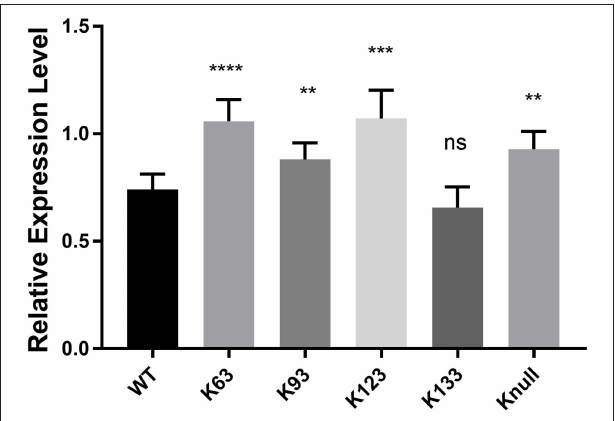
FIGURE 7 | TRP32 lysine mutants exhibit decreased repression of target gene transcription. Wild type and lysine mutant GFP-TRP32, or a GFP control were transfected into HeLa cells with TRP32-target promoter firefly luciferase expression constructs. After 24h luciferase expression was measured and is presented as fold-change from control. Significance was determined using a Student’s t -test (** p ≤ 0.01, *** p ≤ 0.001). Graph is representative of four experiments.